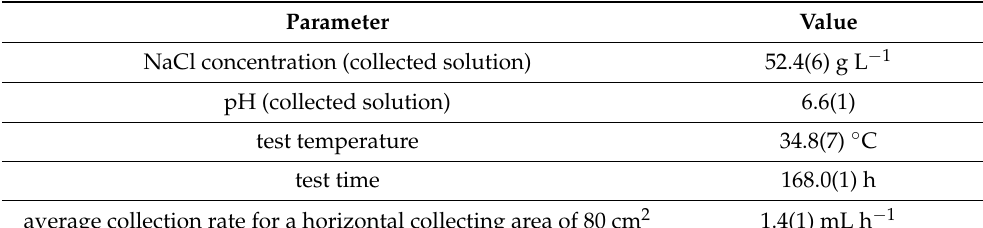
Table 1. Salt spray chamber operating parameters in the NSS test according to ISO 9227:2017